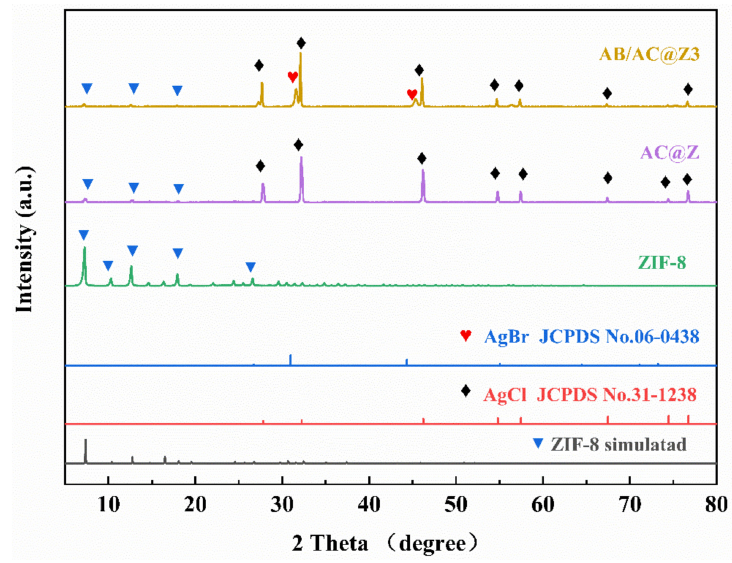
Figure 2. The X-ray diffraction patterns of the prepared